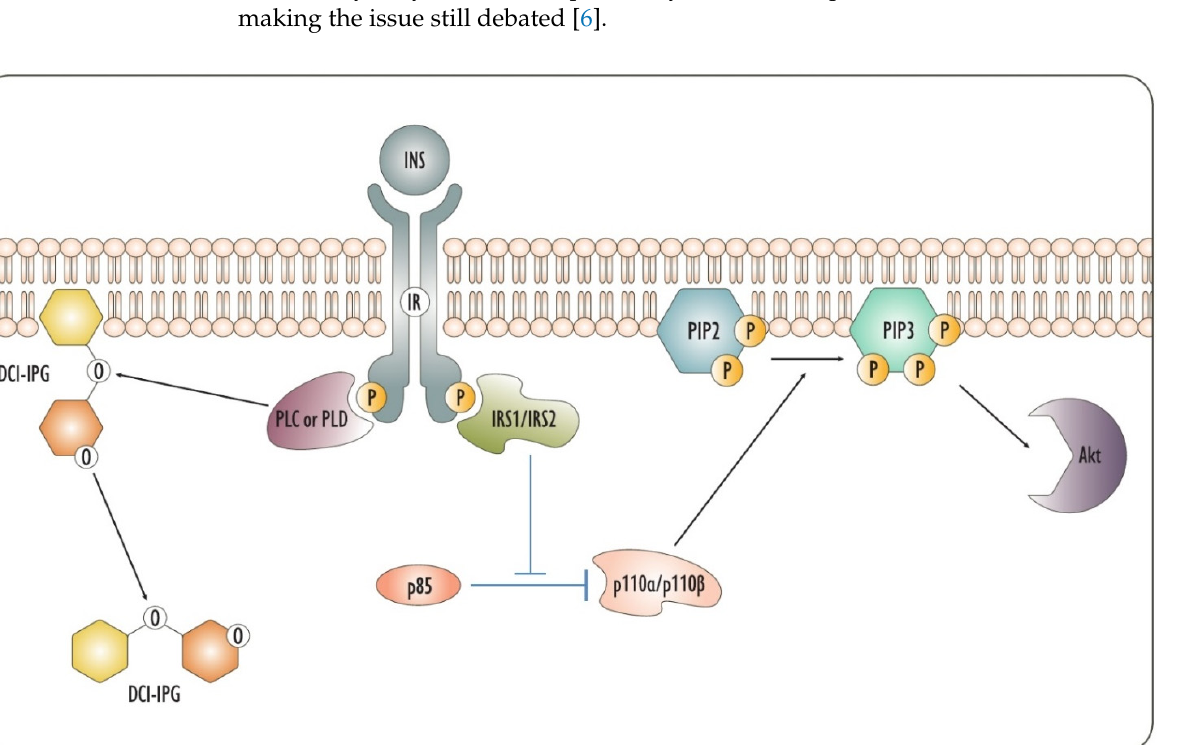
Figure 1. The figure depicts the insulin pathways based on inositol. On the one hand, IRS1 and IRS2 remove the inhibition of p85 on p110, thus promoting the conversion of PIP2 to PIP3, leading to the activation of downstream effectors such as Akt. On the other hand, an enzyme of the phosphodiesterase family, whose identity is, to date, debated and which could be PLC or PLD, cleaves DCI-IPGs from the membrane, allowing downstream transmission of the signal. DCI-IPG: DCI-based inositol phosphoglycans; INS: Insulin; IRS1/IRS2: Insulin Receptor Substrate 1/Insulin Receptor Substrate 2; PIP2: phosphatidylinositol-4,5-bisphosphate; PIP3: phosphatidylinositol-3,4,5-trisphosphate; PLC: Phospholipase C; PLD: Phospholipase D.